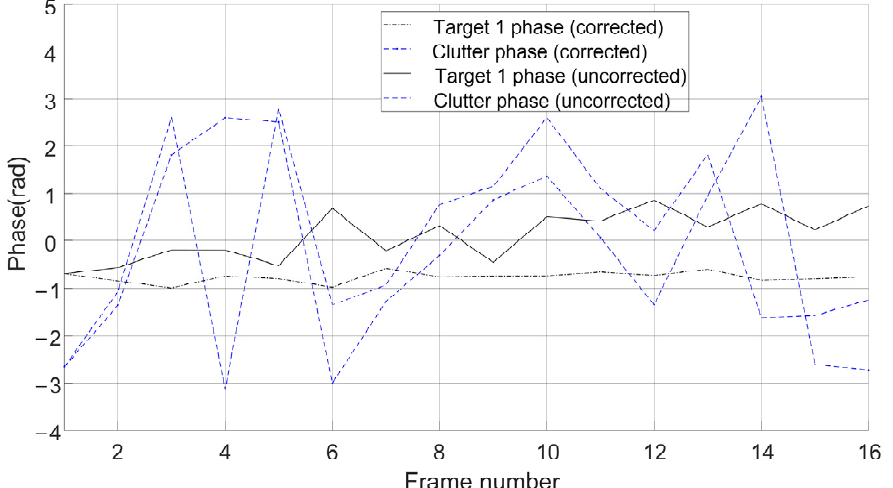
Figure 14. The phase change history of two targets.